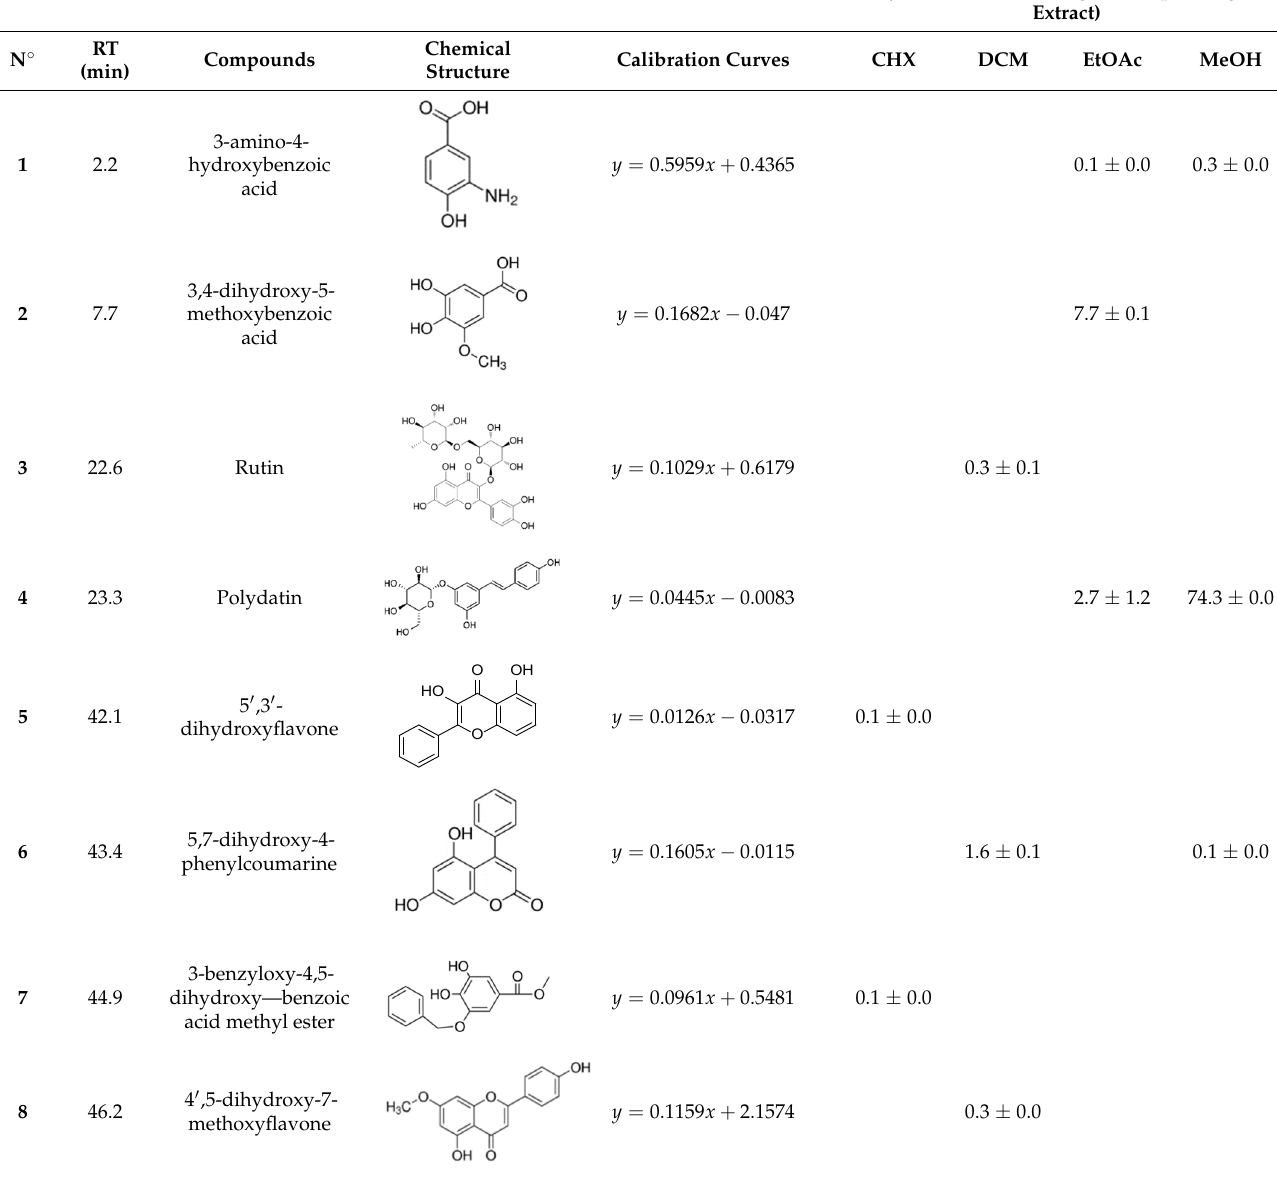
Table 1. Identification and quantification of phenolic compounds in S. fruticosa extracts by HPLC- DAD.